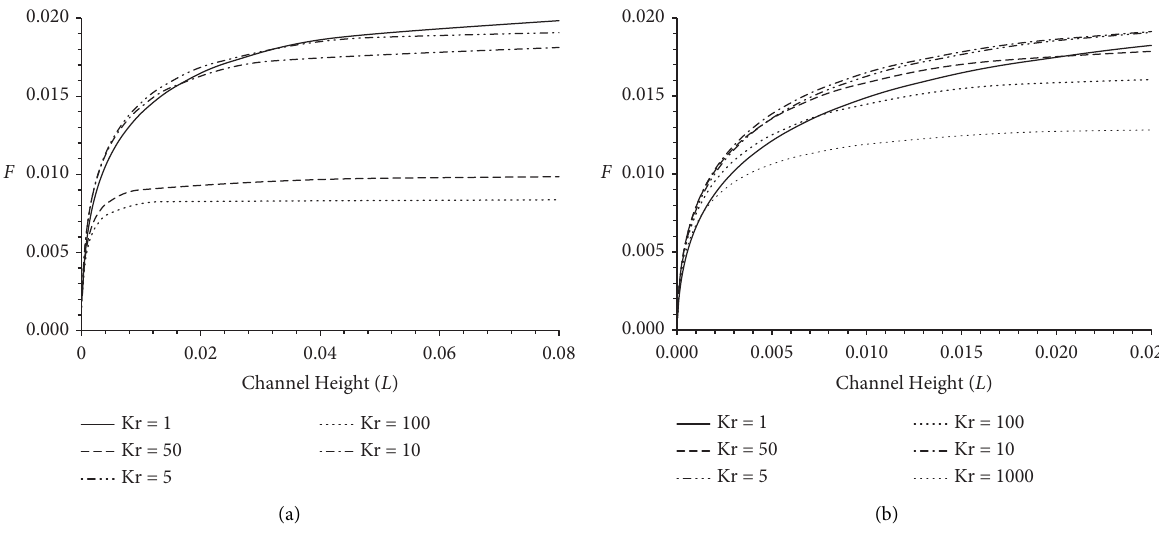
Figure 4: Induced flow rate versus channel height for different K